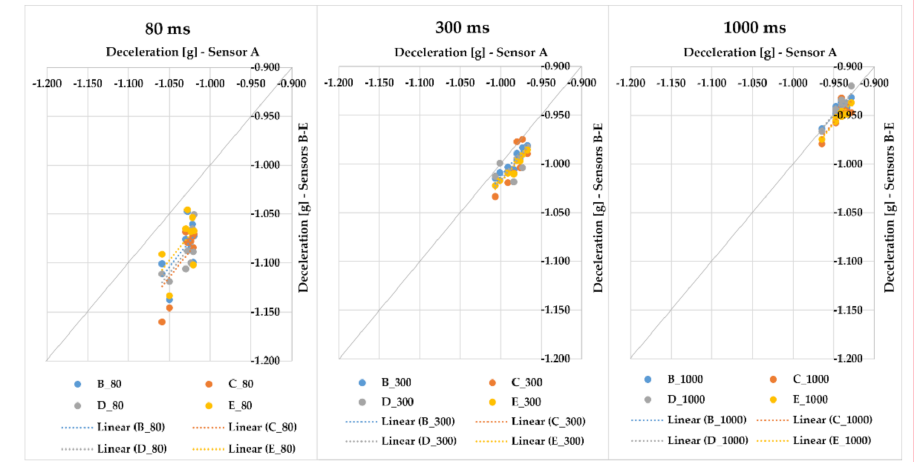
Figure 6. Point dependency of individual microelectromechanical system (MEMS) sensors against sensor A with evaluation times